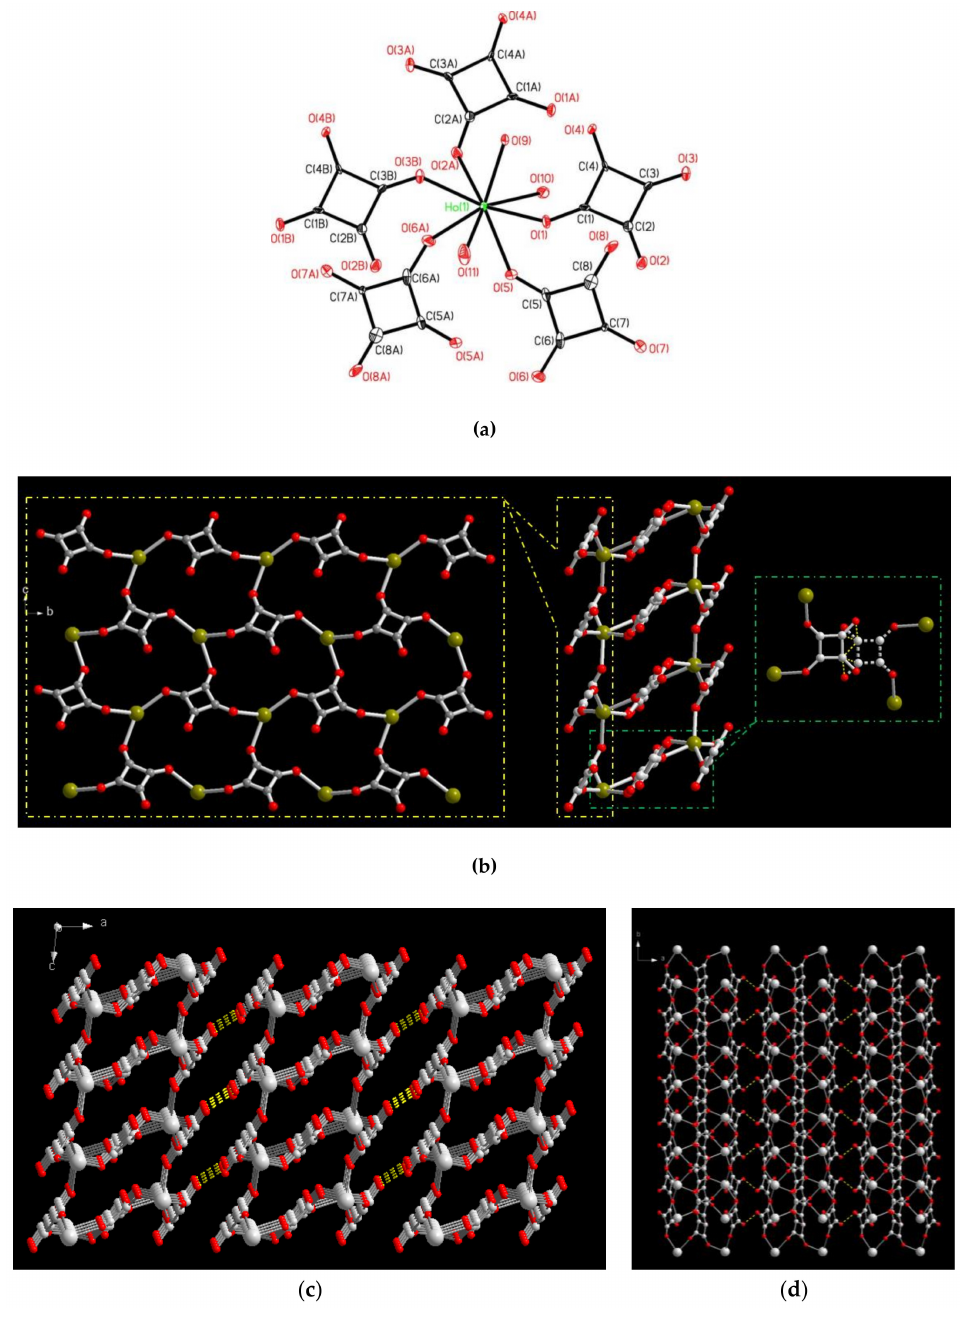
Figure 2. ( a ) A square antiprismatic geometry of Ho(III) ion in 2 with atom labelling scheme (ORTEP drawing, 30%thermalellipsoids)TheHatomsareomittedforclarity. ( b )Left: The2Dlayeredframework via the bridges of Ho(III) ions and µ 1,2,3 -C 4 O 42 − . Middle: The 2D bi-layers MOFs constructed via the bridges of Ho(III) and µ 1,2,3 - and µ 1,2 -C 4 O 4 2 − . Right: The bridges of Ho(III) and disorder µ 1,2 -C 4 O 4 2 − . (red for O atom, gray-white for C atom and green-gray for Ho atom) ( c ) The 3D supramolecular assembly of 2 viewing along the b axis. (red for O atom, and gray-white for Ho and C atoms) ( d ) The 3D supramolecular assembly of 2 viewing along the c